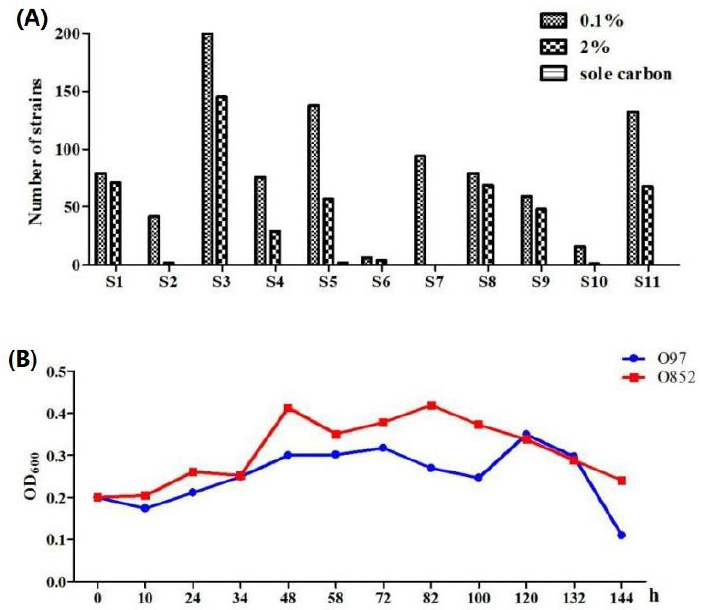
Figure 1. Isolation and screening of limonene-resistant microorganisms. ( A ) Microbial isolate resistance screening results of 11 samples with limonene. ( B ) Effect of 1% limonene on the growth of strain O97 and strain O852 in M9 medium. S1, soil of citrus processing plant; S2, soil of citrus fruits; S3, soil of Jianghan Oilfield; S4, peel of fresh Gannan navel orange; S5, peel of rotten Gannan navel orange; S6, peel of fresh Anyue lemon; S7, peel of rotten Anyue lemon; S8, peel of fresh Guanxi pomelo; S9, peel of rotten Guanxi pomelo; S10, peel of fresh Satsuma mandarin; S11, peel of rotten Satsuma mandarin.